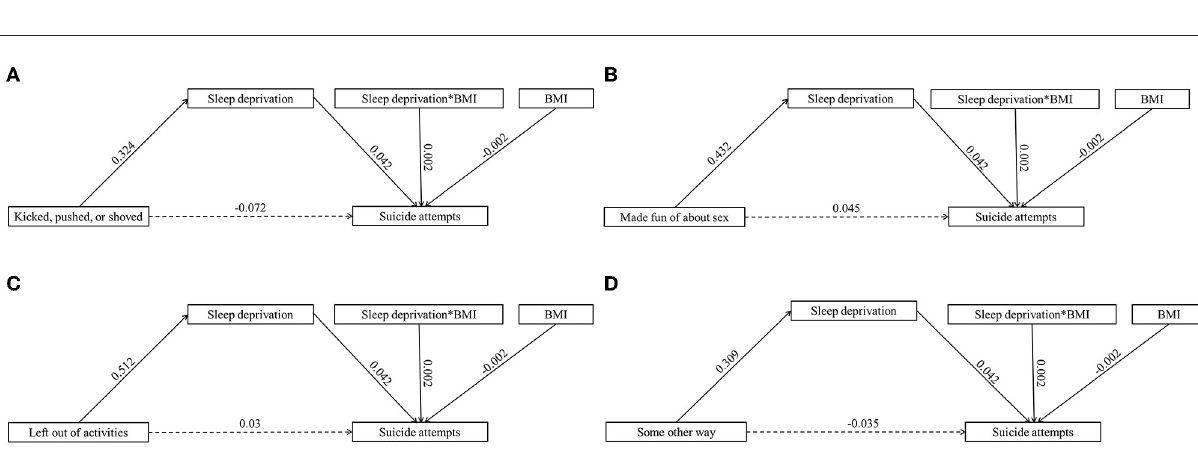
FIGURE2 The moderated mediation model with different types of bullying (full mediating effects) ( n = 121,869). (A) Kicked, pulsed, or showed. (B) Made fun of about sex. (C) Left out of activities. (D) Some other